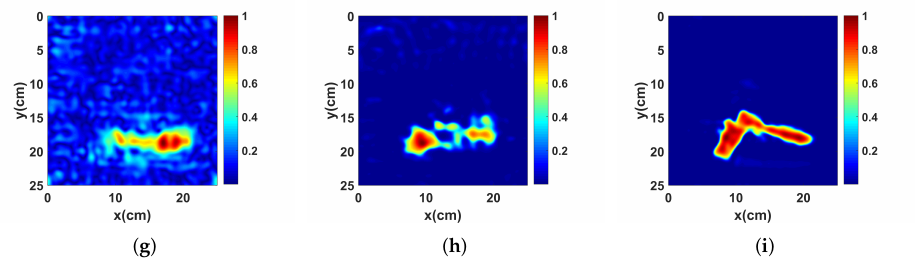
Figure 12. HSR images of Scene IV before and after using different clutter mitigation methods. ( a ) No clutter mitigation. ( b ) Result of PCA. ( c ) Result of the standard SVD. ( d ) Result of the adaptive SVD. ( e ) Result of RPCA. ( f ) Result of MCA. ( g ) Result of the standard autoencoder. ( h ) Result of the proposed method. ( i ) Result of background subtraction.